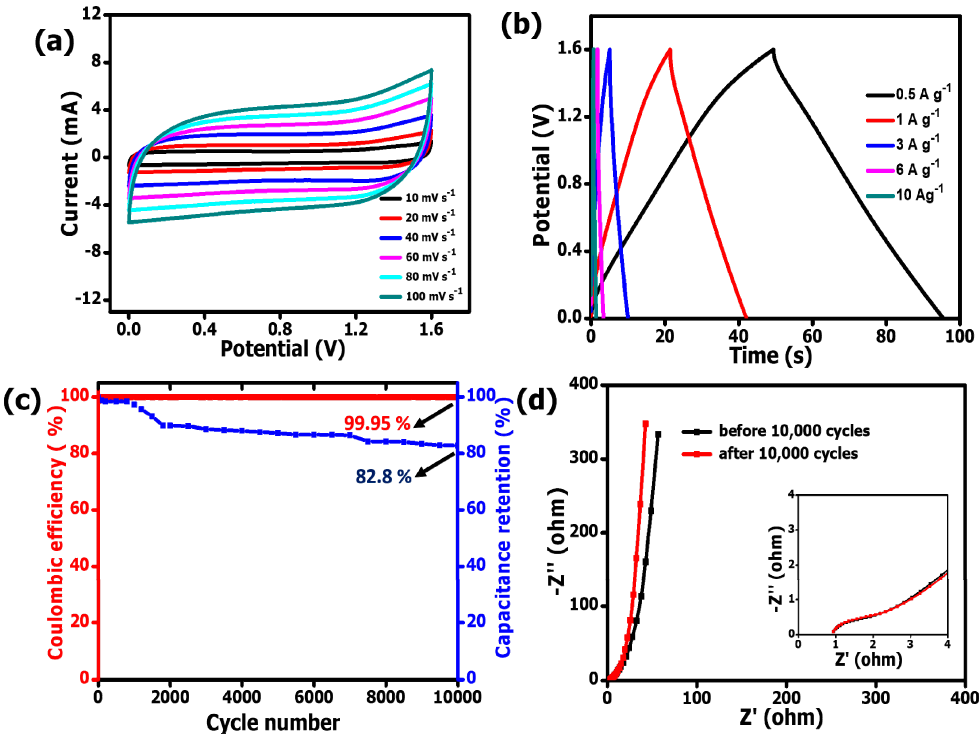
Figure 6. Electrochemical performance of the activated BN-CSs symmetric device showing ( a ) CV curves, ( b ) GCD plots, ( c ) Cycle stability and associated capacitance retention and ( d ) Nyquist plots before and after 10,000 cycles at 2 A g − 1 , respectively.